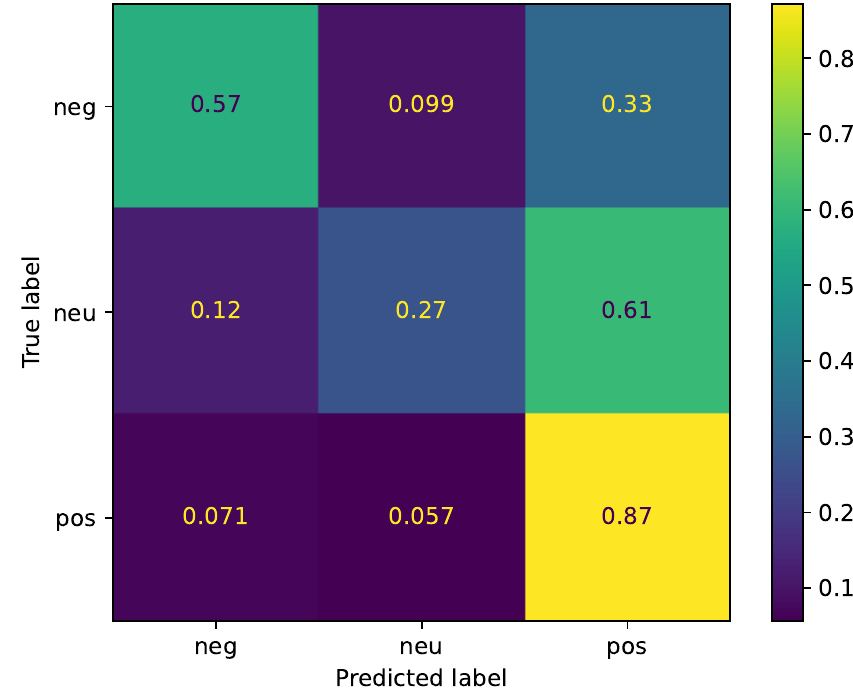
Figure 3. Normalized confusion matrix for three-class sentiment analysis.